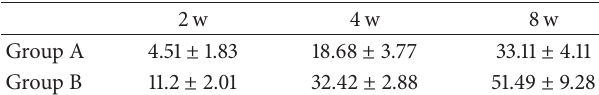
Table 1: Percentage area of trabecular bone in two groups at 2, 4, and 8 weeks ( 𝑥 ±